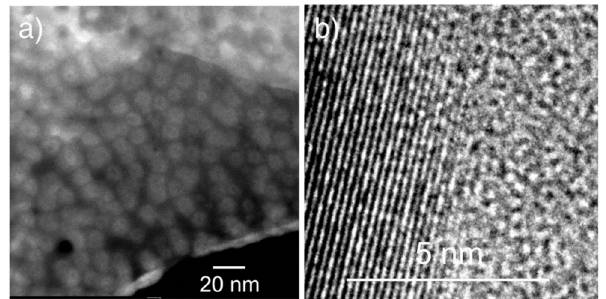
5 nm; Figure 8a) causes the interfacial “conduction tissue” to be ramified and can greatly contribute to the overall conductivity. It should be underlined that the conductivity of crys- talline phase inside grains (LiFePO 4 ) is low, typically 10 − 7 Scm − 1 at room temperature [43]. The conductivity of the glassy matrix is even lower [45].